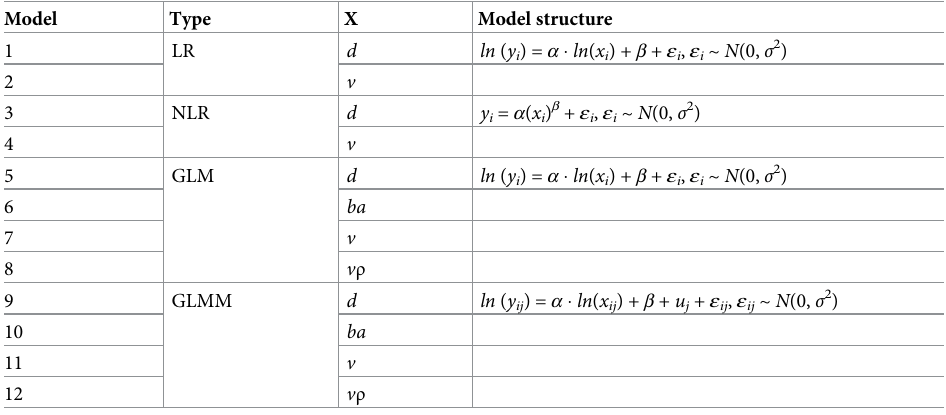
Table 1. Allometric models to estimate individual-tree aboveground biomass of cerrado sensustricto ,based on different explanatory variables (diameter, basal area, volume, and wood density) and species as random effect. Model Type X Model structure 1 LR